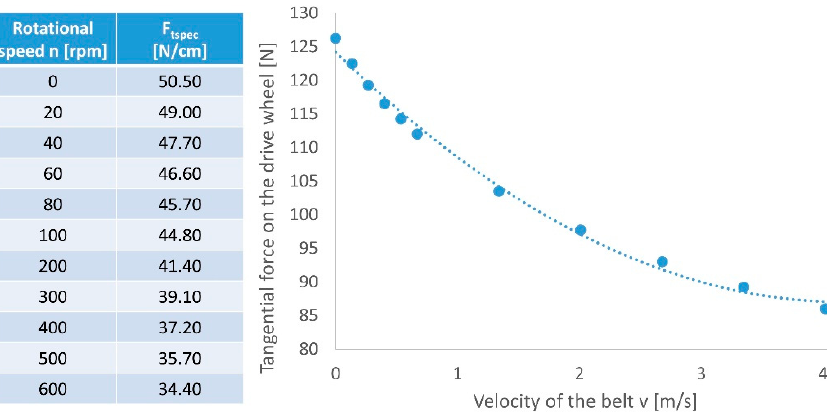
Figure 7. The catalog data for the belt regarding the influence of rotation speed n (rpm) on the allowable distributed load on a single tooth F tspec (N/cm) together with the characteristic of the tangential force as a function of the belt linear velocity for belt wheel diameter D = 128 mm and belt width W = 25 mm [28].